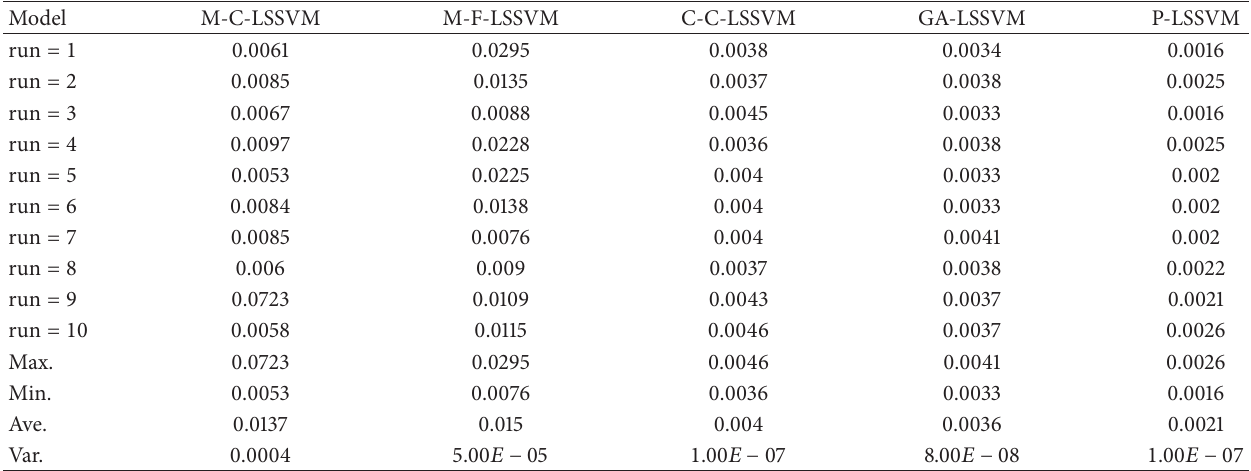
Table 11: Five models predicted error based on MAPE for FM broadcasting